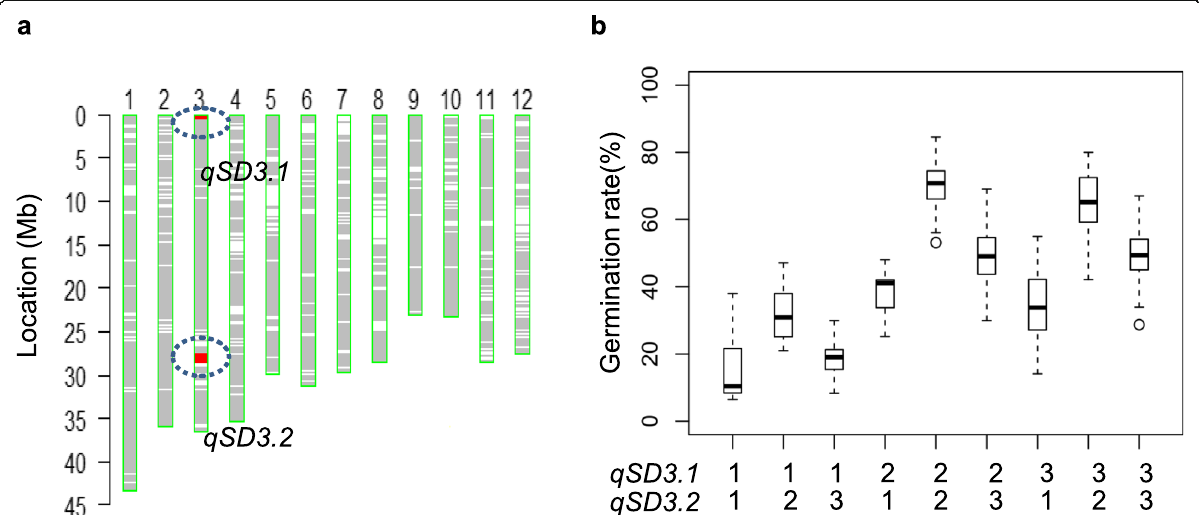
Fig. 5 Epistatic interaction of qSD3.1 and qSD3.2 . a Graphical genotype of one CSSL (NY61) encompassing qSD3.1 and qSD3.2 . The red and green bars represent the Nipponbare (NIP) and 9311 genotypes, respectively. b Boxplots of nine genotypes at the two loci for germination rate at 72 h after imbibition in the NY61-derived population ( n = 175). Box edges indicate the range of the 25th to 75th percentiles, with the median value shown by the bold middle line. “ 1 ” , “ 2 ” and “ 3 ” represent the NIP, 9311 and heterozygous genotypes,